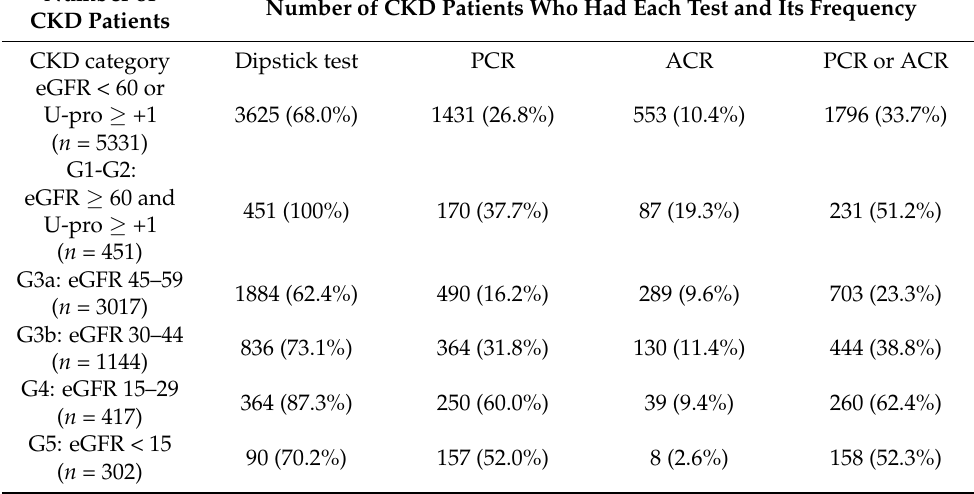
Table 3. Frequency of testing for proteinuria or albuminuria within 1 year of CKD